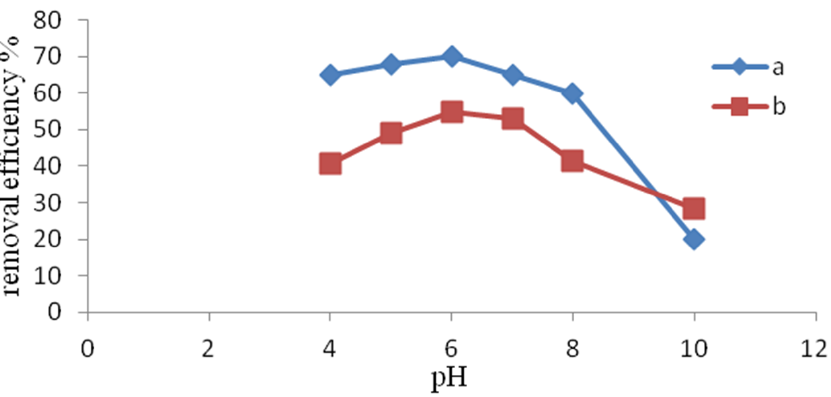
Figure 2. Influence of pH on the efficiency of NH 4+ removal from ( a ) distilled water, ( b ) tap water.